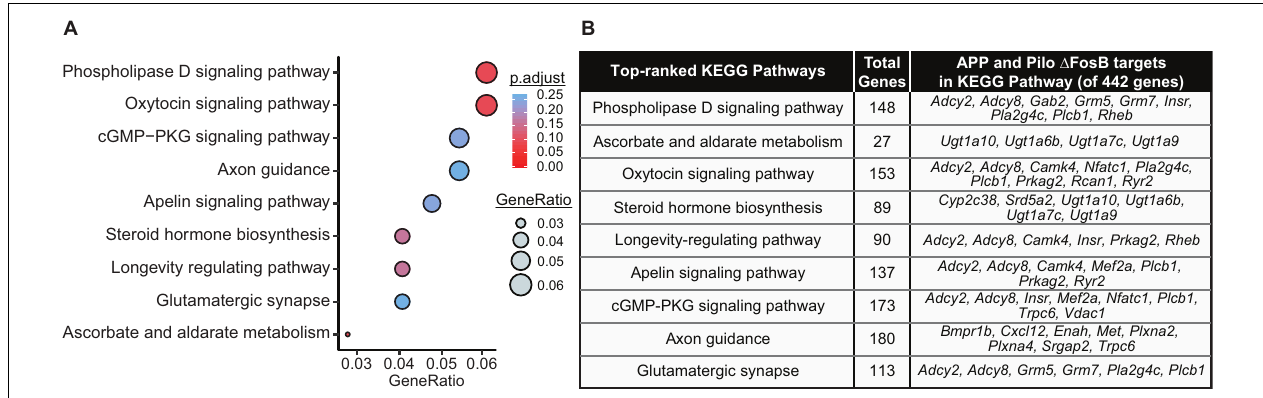
FIGURE 4 | Pathway analysis of (cid:49) FosB targets in APP and Pilo mice highlight neurotransmission and neuroprotection-related pathways. (A) KEGG pathway over-representation analysis on the subset of 442 target genes bound by (cid:49) FosB in both APP and Pilo mice. Bubble chart shows enrichment of target genes in various signaling pathways (y-axis). Gene ratio (x-axis) is the ratio of the number of target genes enriched in the specific pathway relative to the number of target genes in any pathway. The gene ratio and p -value (calculated by hypergeometric test with Benjamini-Hochberg correction) of each pathway are indicated by the size and color of its corresponding circle, respectively. (B) List of target genes associated with each enriched KEGG pathway.